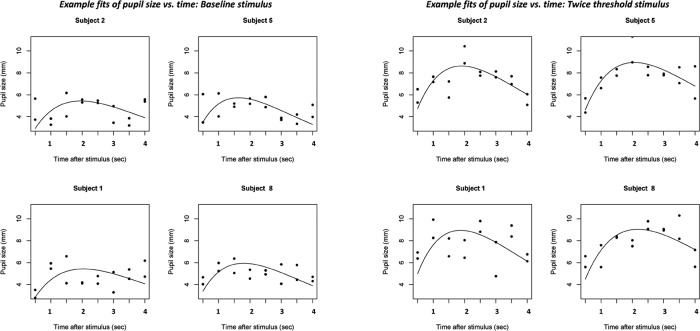
Example hierarchical fits of pupil size versus time for 4 (randomly selected) subjects.Left panel, 4 baseline stimuli and right panel same 4 subjects’ stimuli at twice threshold. Each time point has mechanical and chemical stimulus measurements.